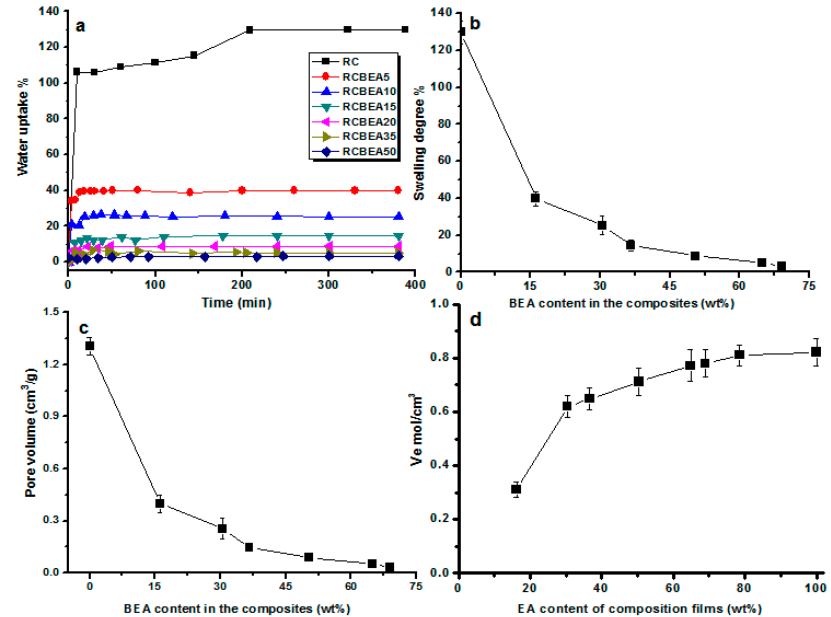
Figure 6. Water uptake ability of the films with a different content of loaded resin ( a ); and the effects of epoxy resin content on the swelling degree of the films ( b ); volume of pores in the films estimated with the uptake of water as a function of the resin content ( c ); and the degree of cross-link ( V e ) with the composite films as a function of the resin content ( d ).